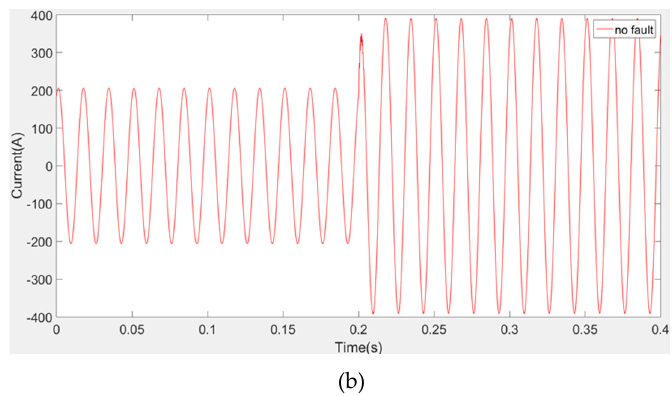
Figure 9. Current waveform measured at CBj2. ( a ) Current waveform at no fault condition; ( b ) Current waveform at fault condition.